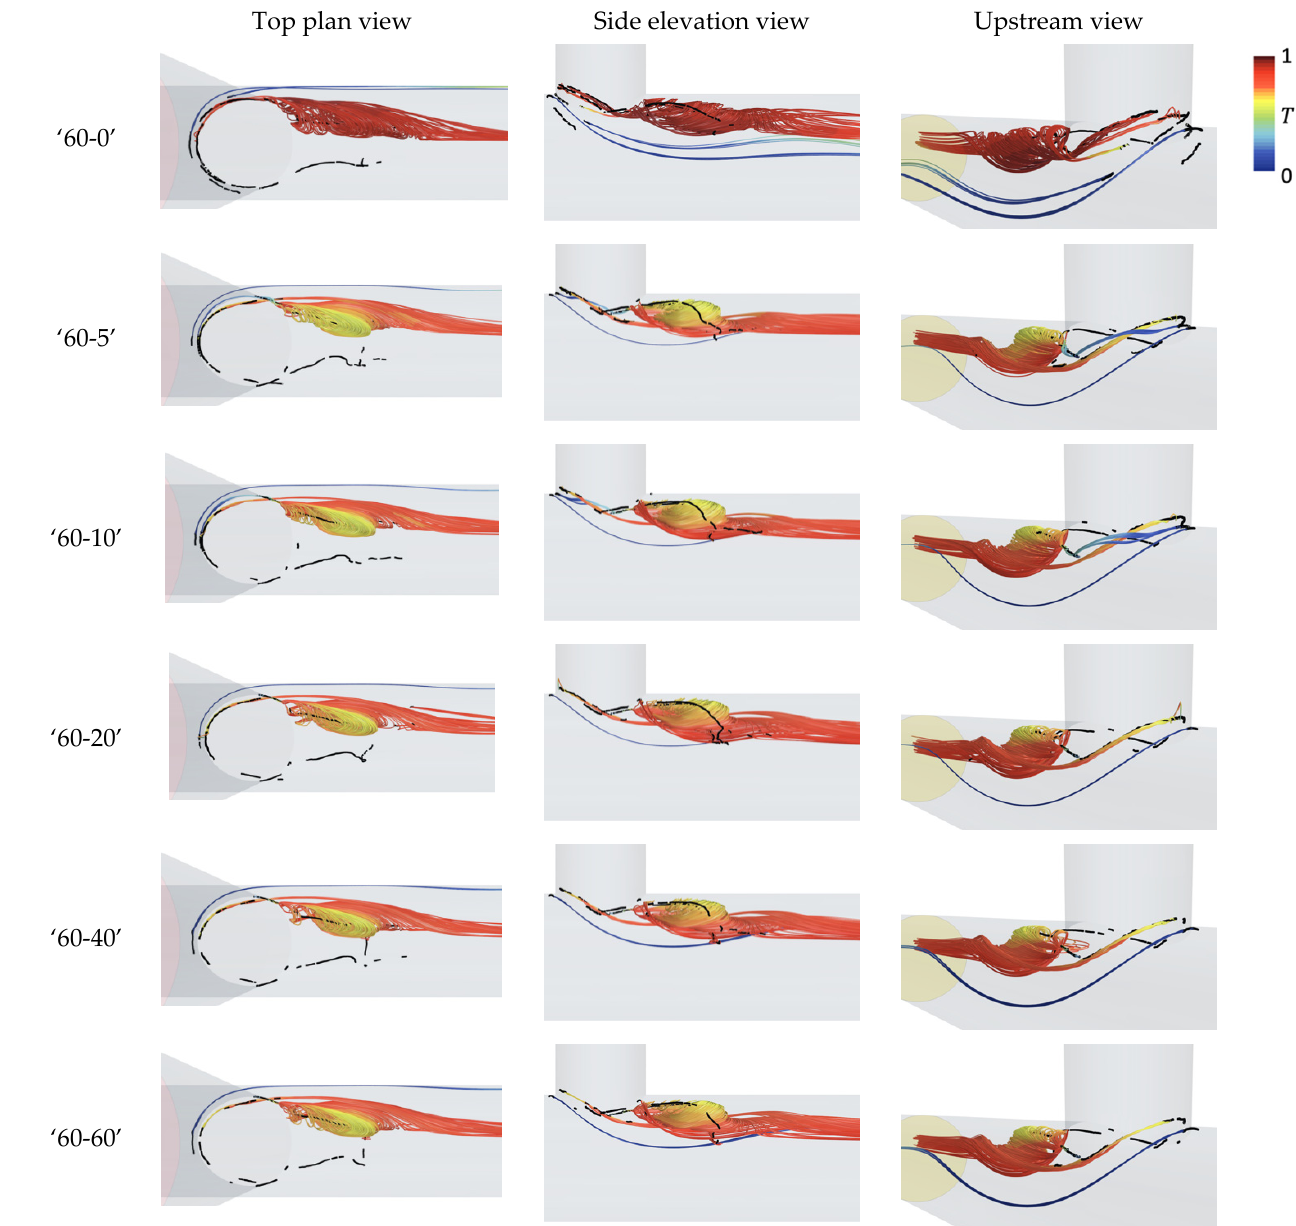
Figure 18. Cases with uniformly distributed BCs at the main inlet—Streamlines generated by vortex core lines (indicated in black) and coloured by 𝑇 ∗ . Left: top plan view, centre: side elevation view, right: upstream view.